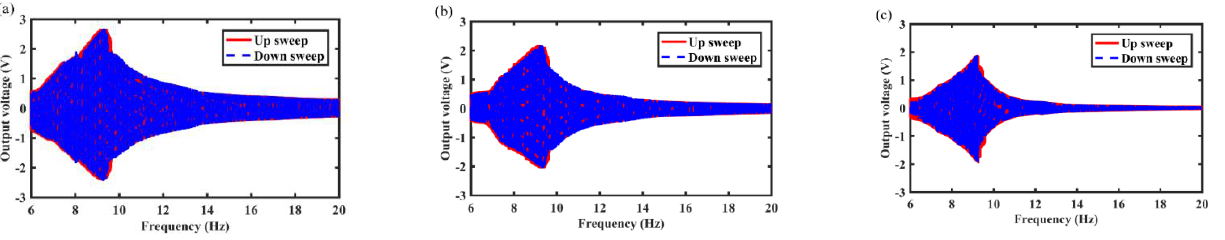
Figure 7. Frequency sweep response of the MCEEH with excitation acceleration of 0.7 g: ( a ) coil 1; ( b ) coil 2; ( c ) coil 3.